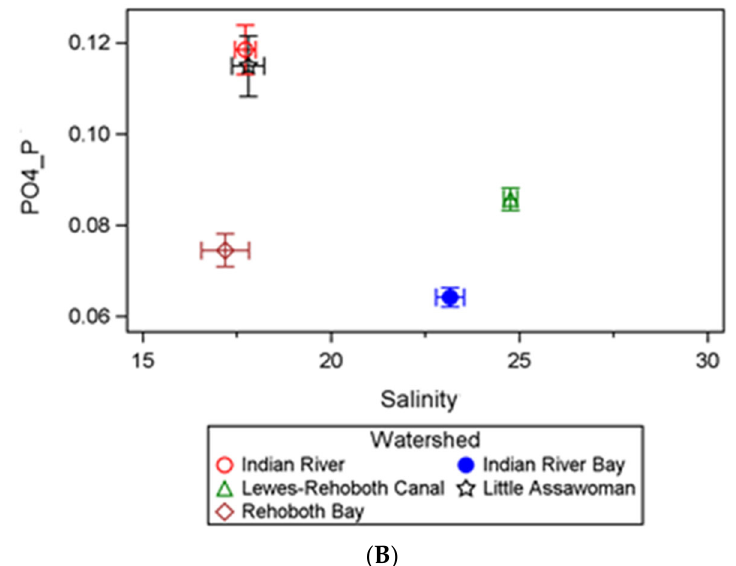
Figure 2. ( A ) Dissolved nitrogen–nitrite+nitrate (N ‐ NO 2_3 ) and ( B ) phosphorus–phosphate (P ‐ PO 4 ) concentrations in mg/L along the salinity gradients of the five watersheds. Lengths of whiskers ex ‐ plain the ranges in vertical and horizontal